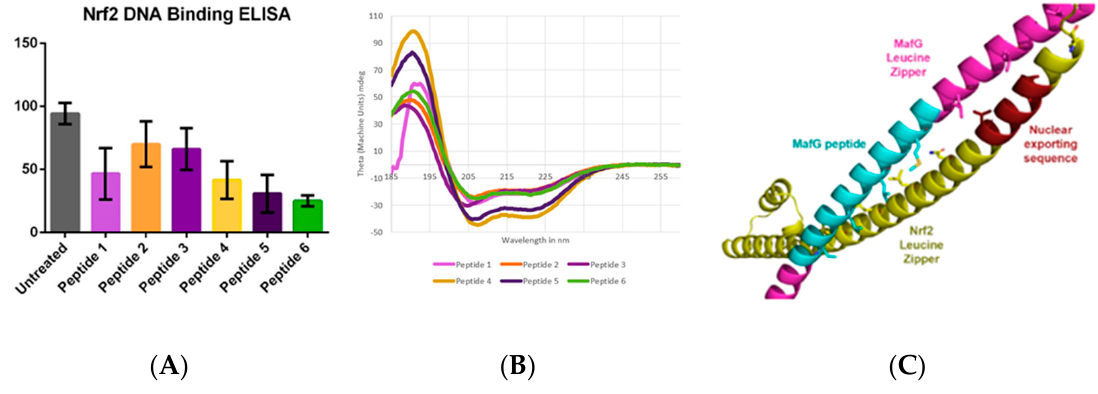
Figure 22. ( A ) Nrf2 DNA Binding ELISA presented as a percentage over vehicle control; ( B ) Circular Dichroism of Peptides 1-6 in 50:50 TFE: Potassium Phosphate Buffer; ( C ) AlphaFold model of the Nrf2-MafG PPI.